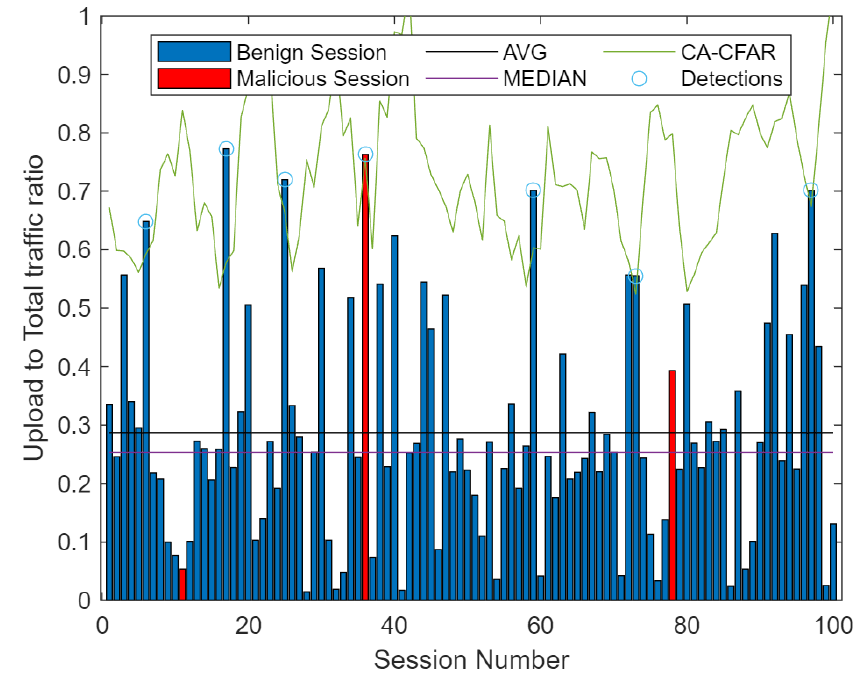
Figure 18. The designated threshold for 10 training cells and 4 guards cells. Upload ratio.